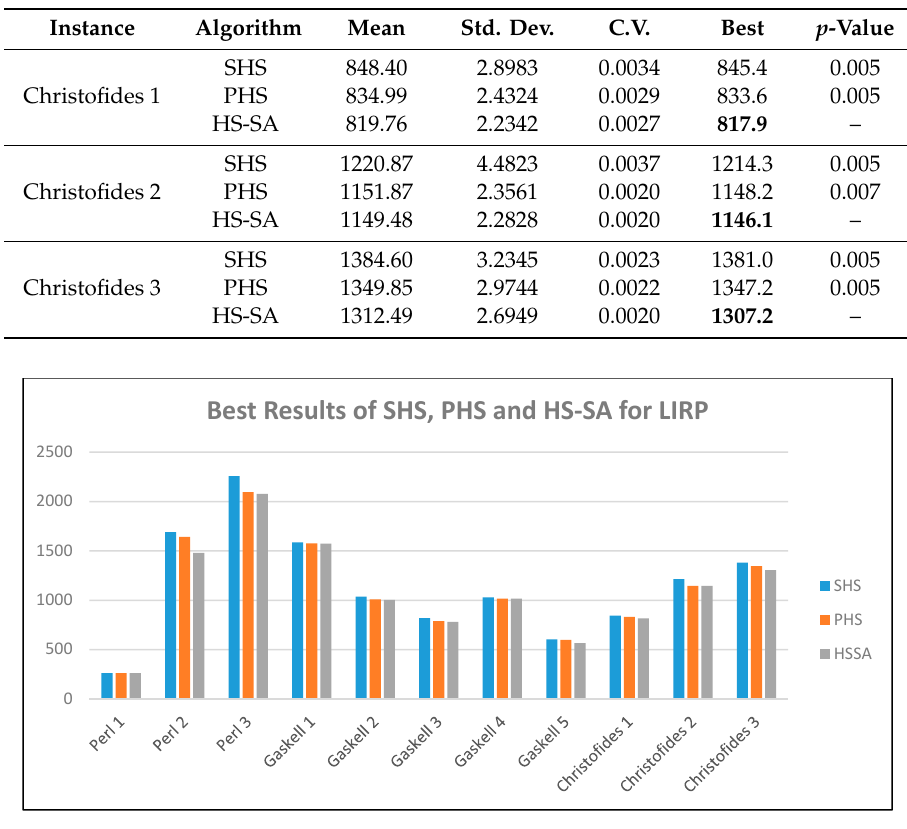
Table 8. Comparative results of Gaskell dataset in LIRP for SHS, PHS, and HS-SA.